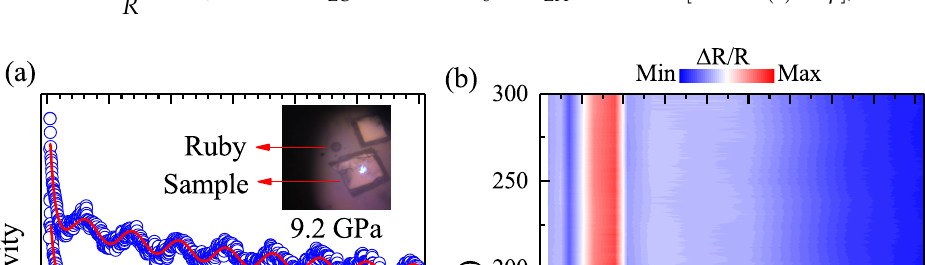
∆ R at different pressures. R